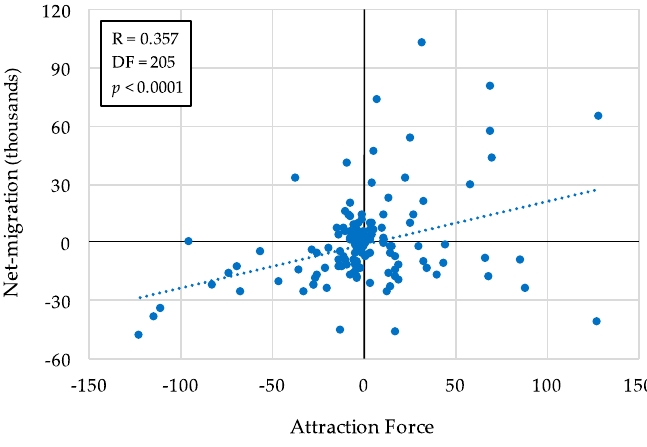
Figure 9. Population attraction forces in 2010 and observed net migration during 2011–2015.